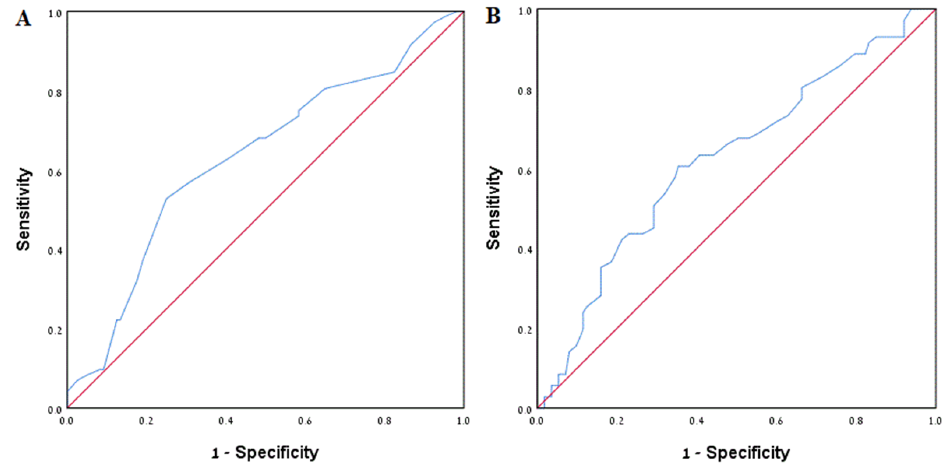
Figure 2. ROC curves. ( A ) ROC curve for baseline calcium; AUC = 0.632; ( B ) ROC curve for baseline uric acid; AUC = 0.624.